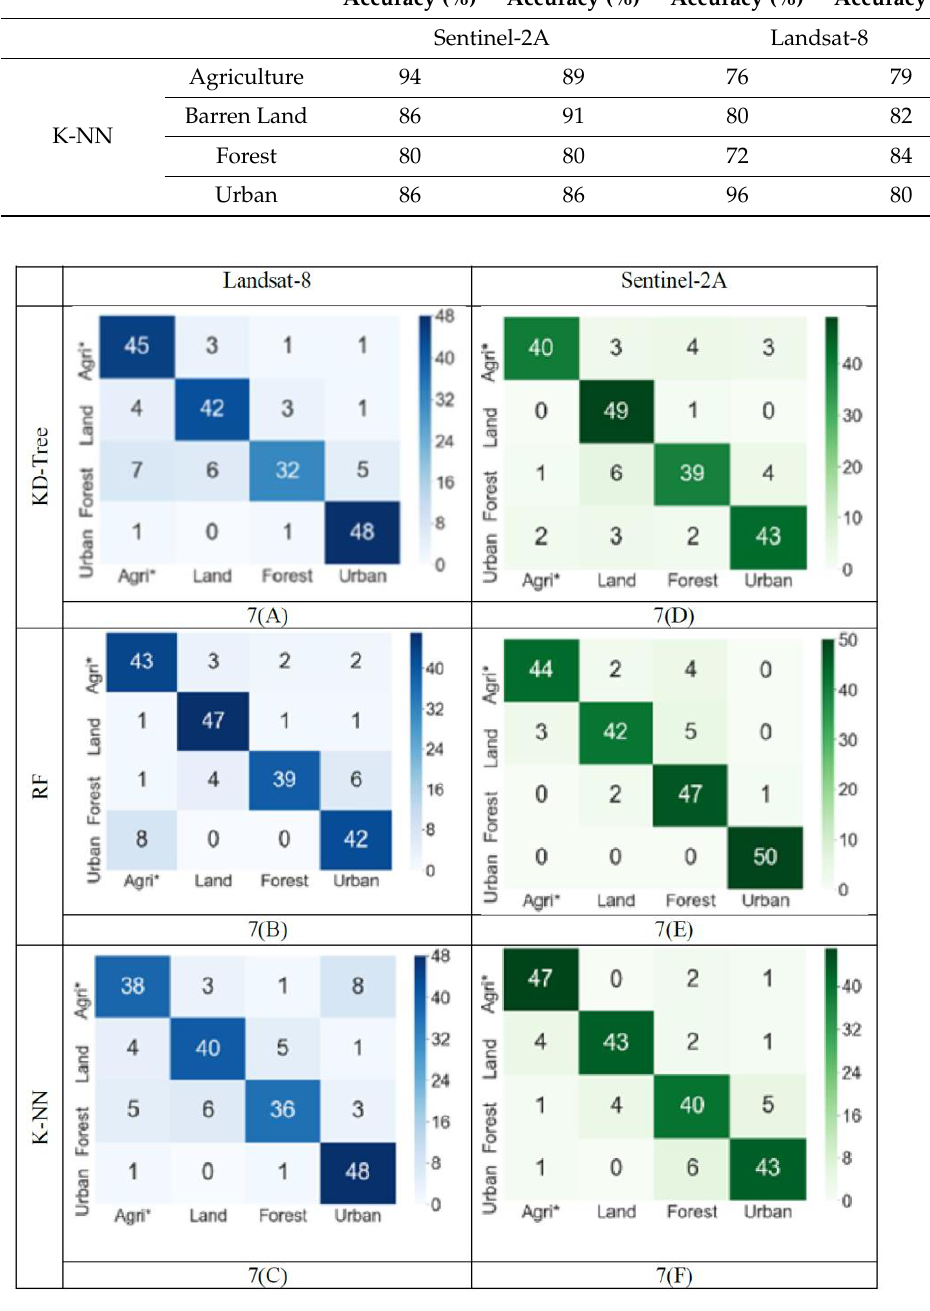
Figure 7. Error matrix showing correct and incorrect training vectors of the evaluation samples by each ML algorithm. The error matrices for Landsat-8 data are shown in Figures ( A – C ). The error matrices for Sentinel-2A data are shown in Figures ( D – F ). Table 4 shows the producer and user accuracy calculated based on the error matrices. Table 4. User and producer accuracies for LULC types used in this study.